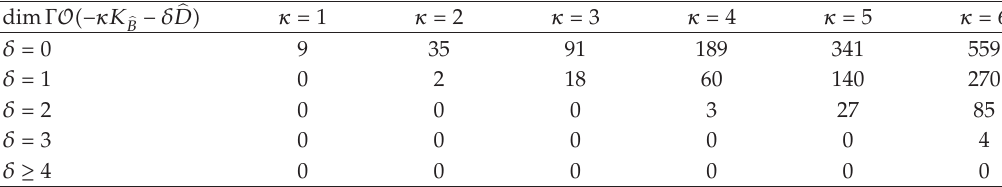
− δ (cid:16) D (cid:3) , see also Figure B